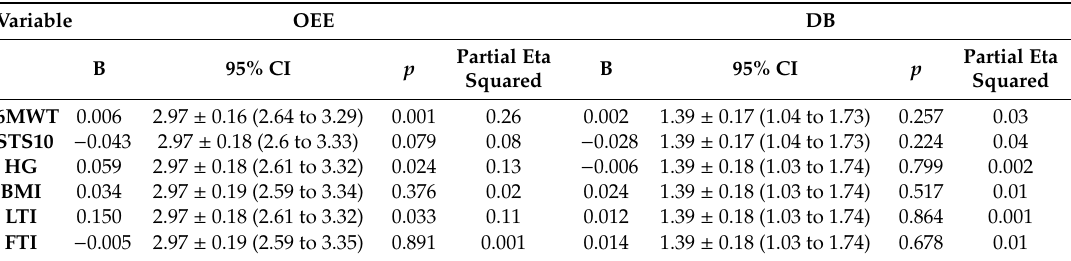
Table 3. Associations of baseline physical performance and body composition indices with baseline questionnaire scores.